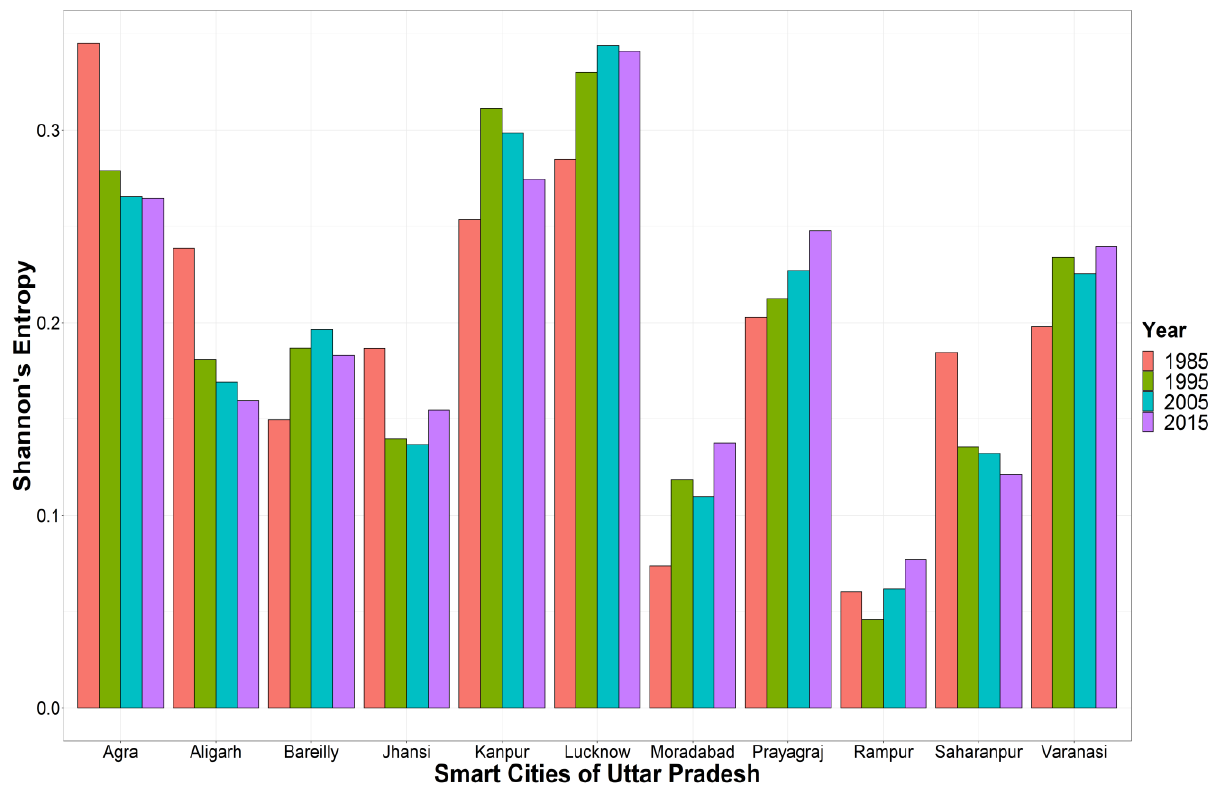
Figure 6. Shannon’s Entropy ( H n ) value across 11smart cities of Uttar